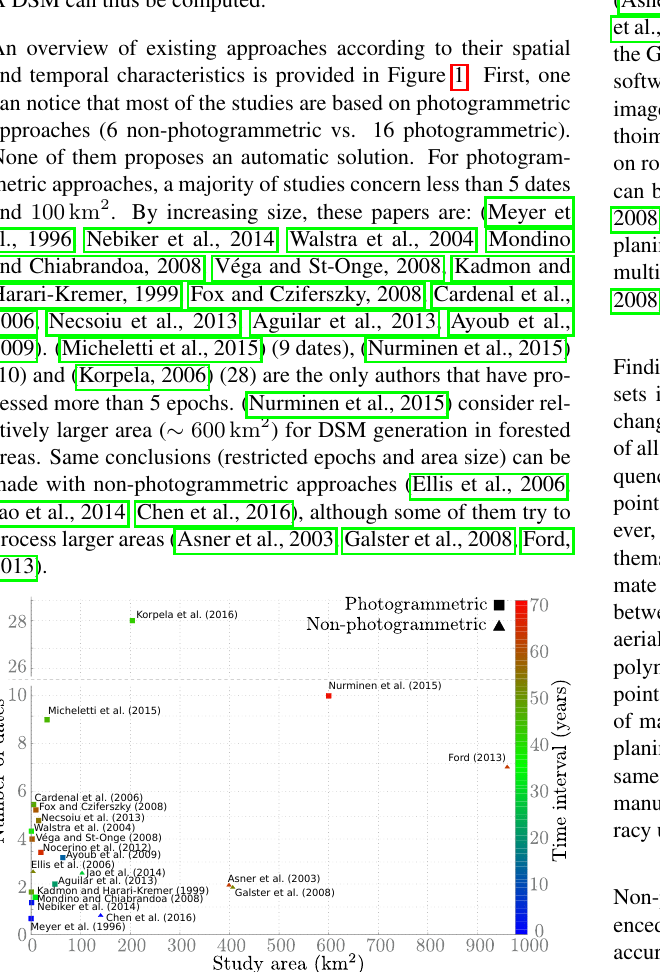
Figure 1. Spatio-temporal overview of state-of-the-art studies. Papers are plotted according to the area of the study site, the number of dates and the time range of the time